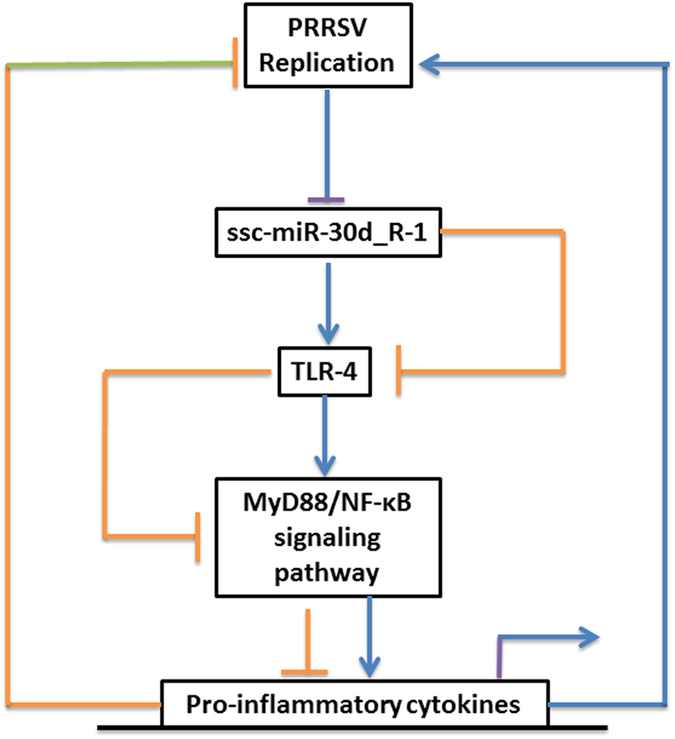
The possible mechanism of the suppressive effect of ssc-miR-30d_R-1 on PRRSV replication.PRRSV infection downregulates the expression of ssc-miR-30d_R-1 (targets TLR4), which activates the TLR4/MyD88/NF-κB signaling pathway, resulting in promotion of PRRSV replication. Conversely, overexpression of the ssc-miR-30d_R-1 mimic inhibits TLR4, which inhibits the TLR4/MyD88/NF-κB signaling pathway, resulting in reduced PRRSV replication.